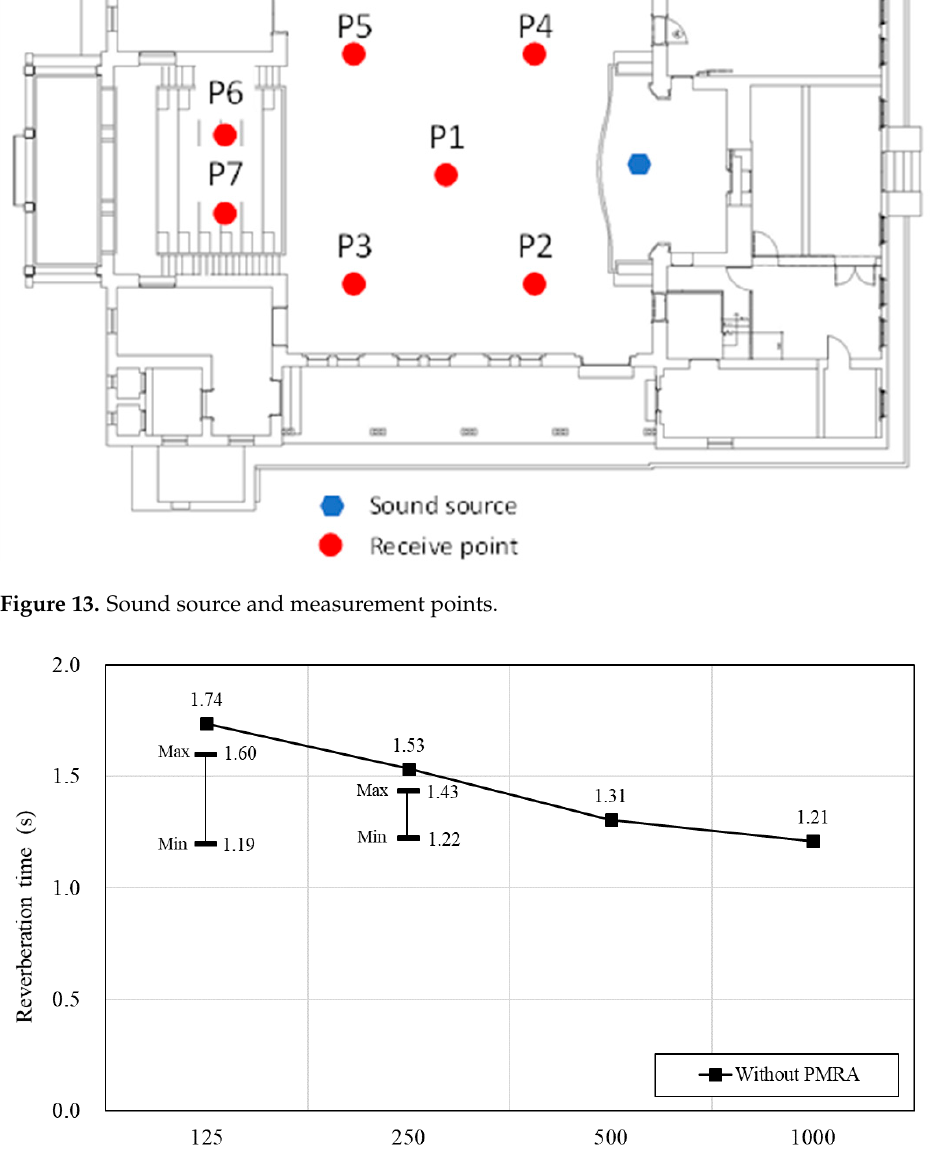
Figure 14. RT of Ge-Chi Hall without panel membrane resonant absorber (PMRA).